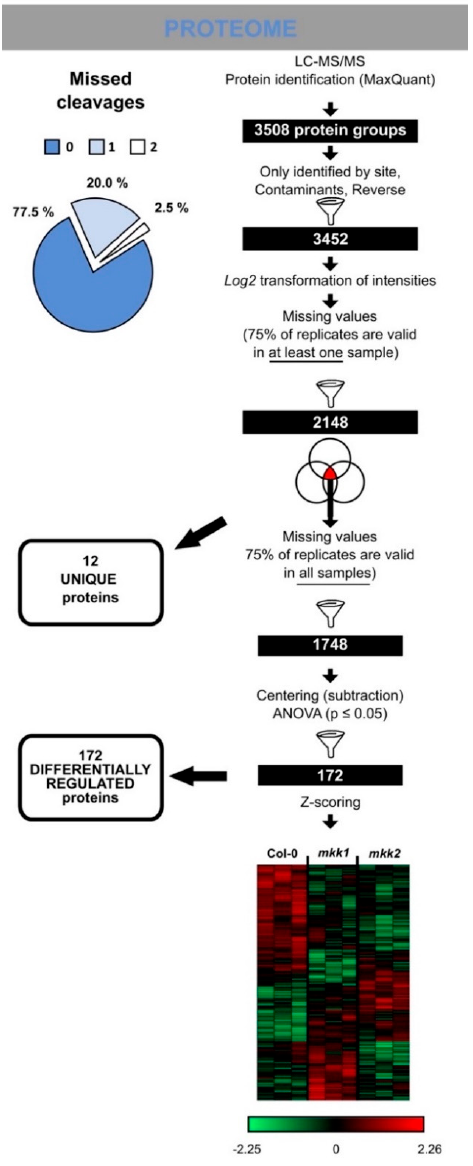
Figure 6. Protein changes in mkk1-2 and mkk2-1 mutants. Workflow illustrating the steps to obtain a reliable set of proteins or phospho-sites following LC-MS/MS. Venn diagrams indicate steps where “unique” proteins/phosphosites (with corresponding numbers) were filtered out from the statistical analysis. Heatmap depicts statistically significant proteins based on Pearson correlation. Centred Z-scored log2-transformed intensity values on heatmap are colour-coded according to provided colour gradient scale. The blue pie chart shows missed cleavages of tryptic peptide bonds for the proteome